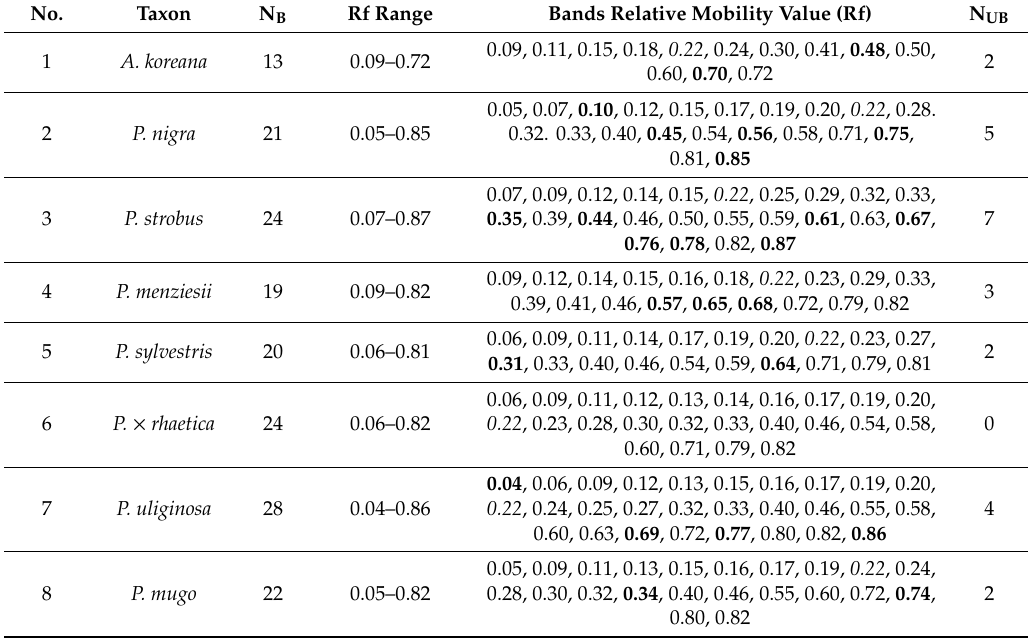
Table 1. Summary of STP profiles for the Pinaceae taxa under study. Unique bands for taxa are given in bold. The single band common to all of the taxa is given in italics. N B —number of bands; N UB —number of unique